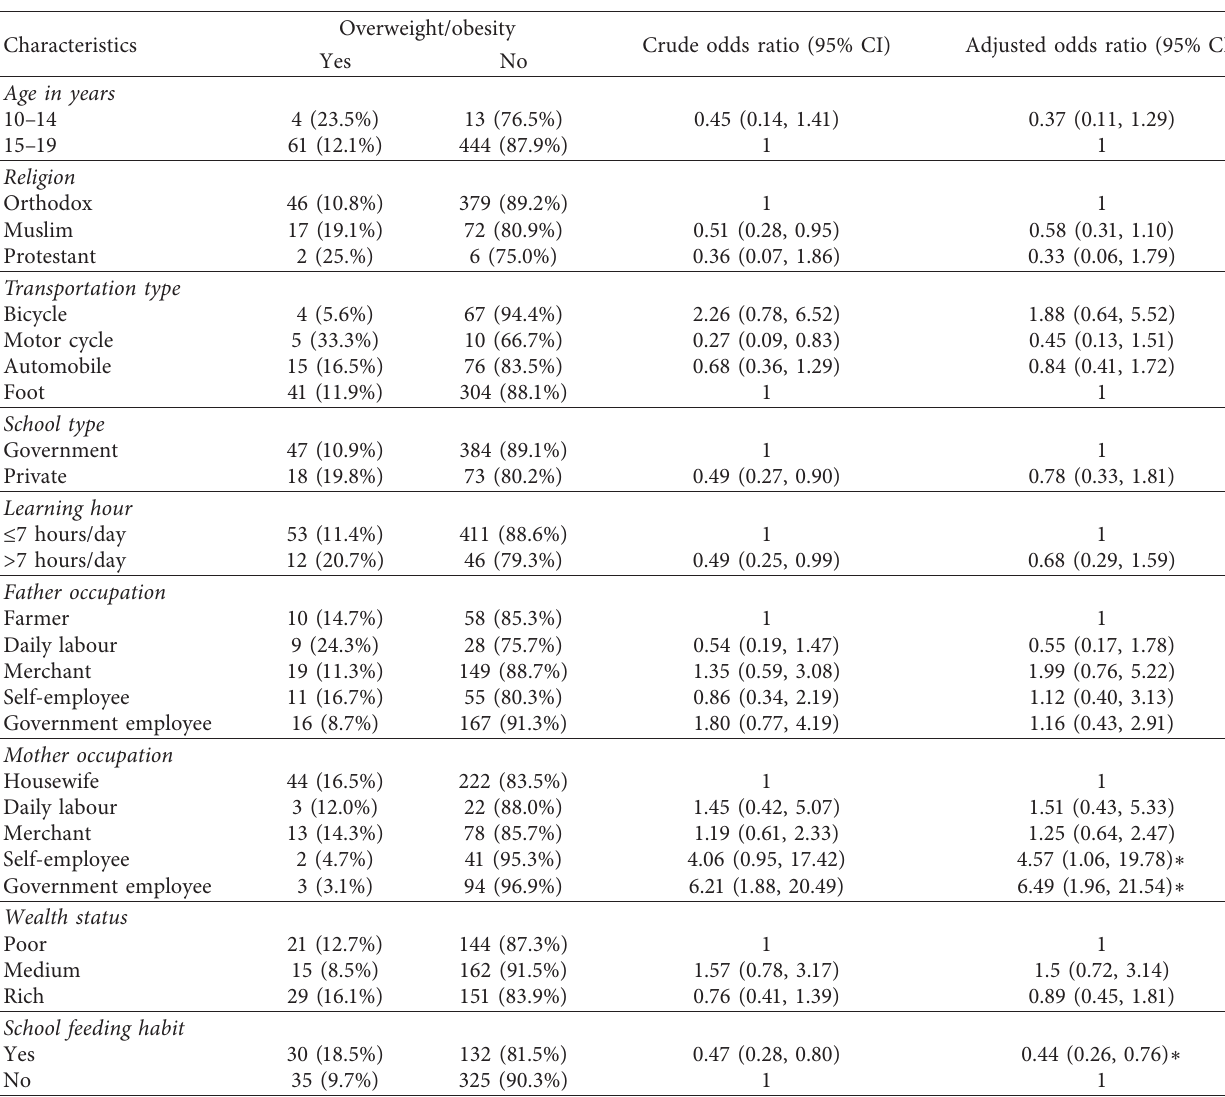
Table 3: Factors associated with overweight and obesity among high school adolescents at Bahir Dar city, northwest Ethiopia.